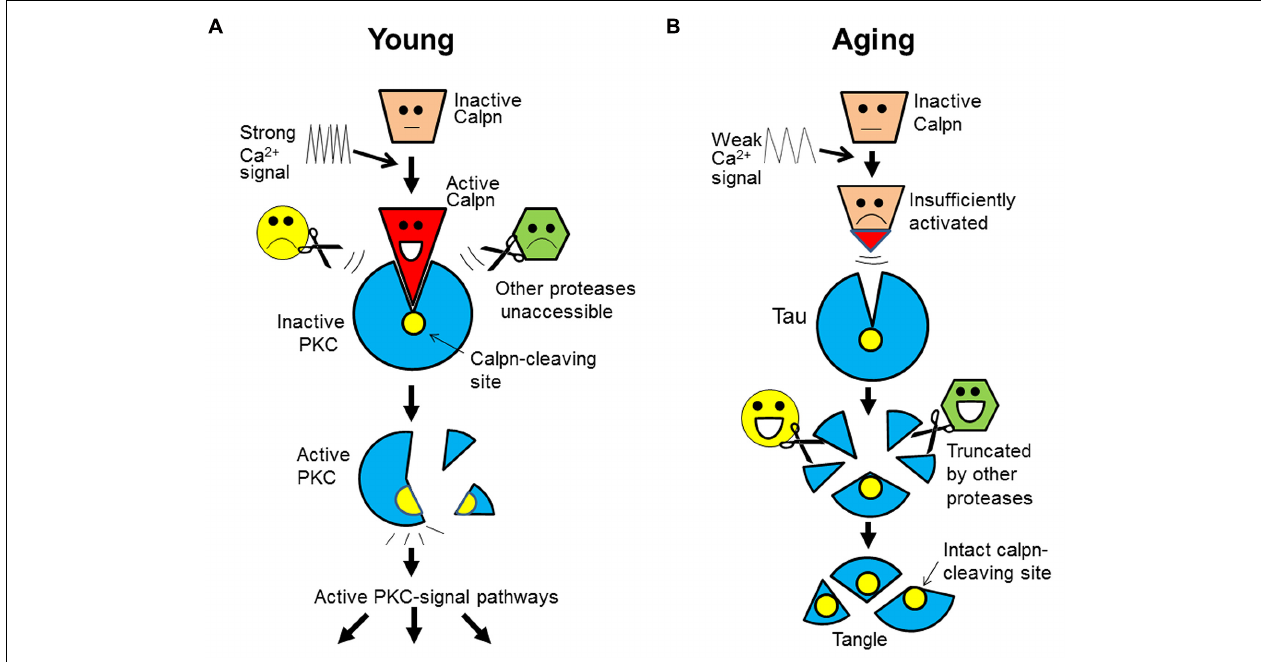
FIGURE 2 | A “ligand-receptor” model for calpain-substrate interaction and selective accumulation of calpain substrates in brain aging. (A) In the young, calpain substrate (e.g., PKC) assumes a “receptor-like” configuration that is exclusively accessible by active calpain (as